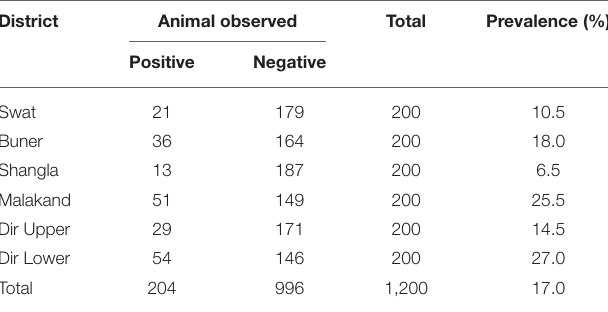
TABLE 2 | Prevalence of cystic echinococcosis among different districts of the Malakand division.